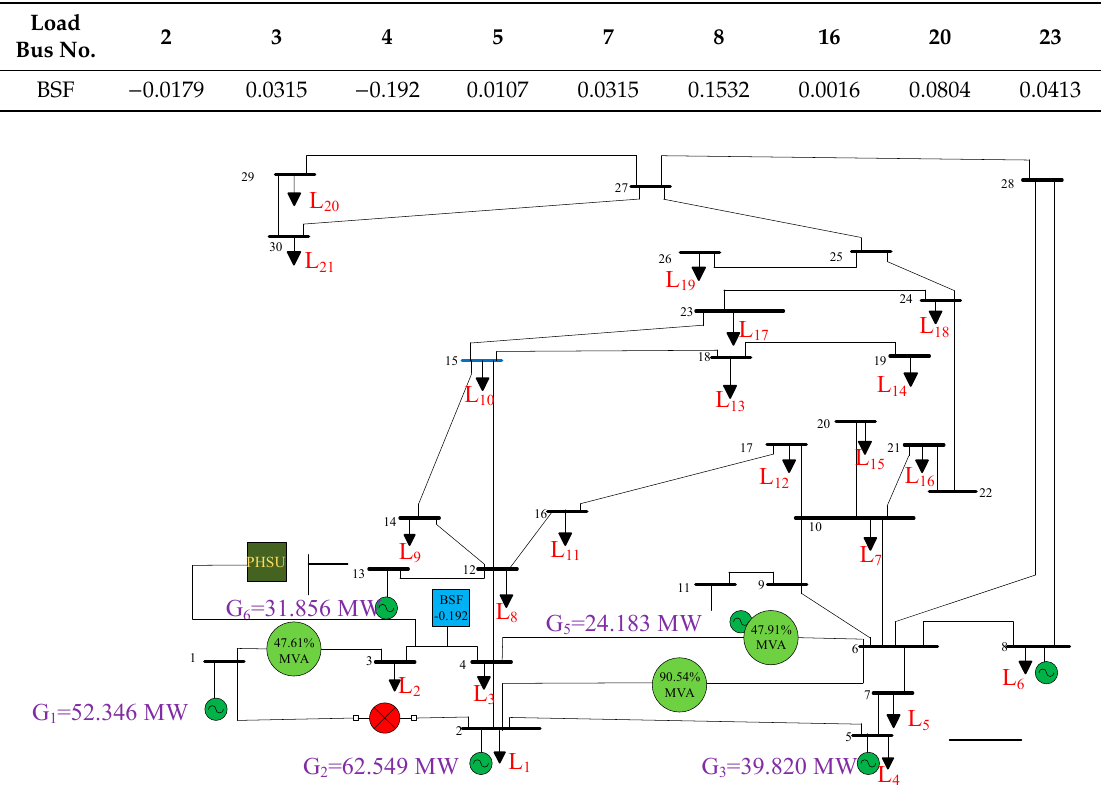
Table 7. Sensitivity factor without PHSU.